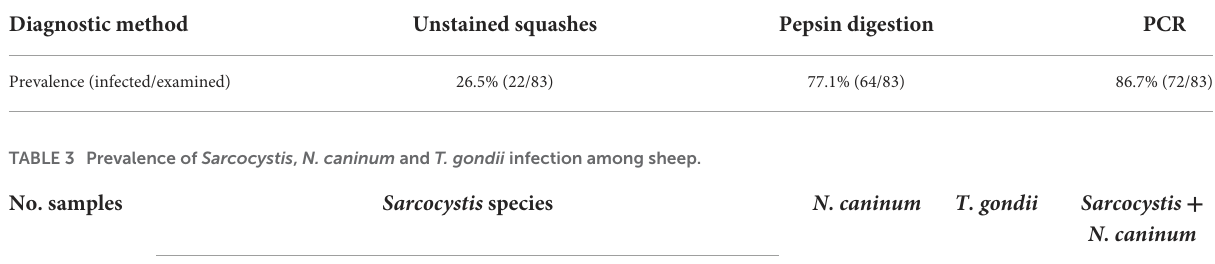
TABLE 2 Prevalence of Sarcocystis spp. infection among sheep according to the diagnostic method.